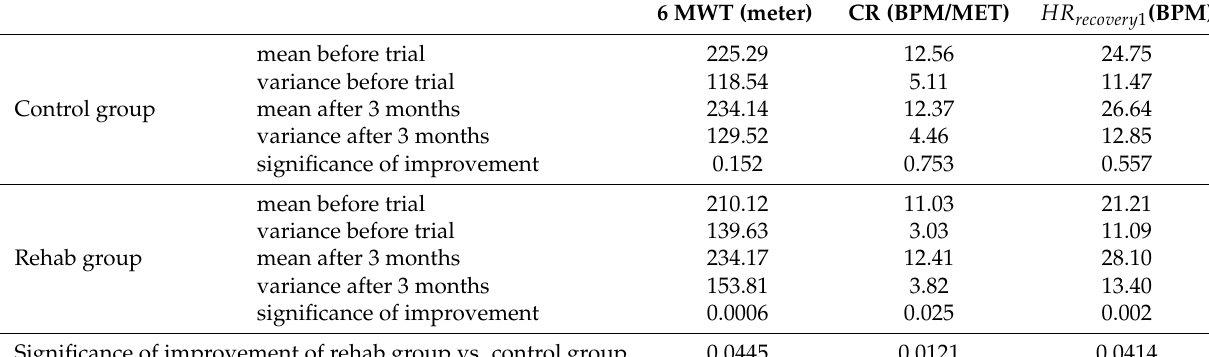
Table 3. Comparison of 3-month rehab results between control group and rehab group under 3CT objective evaluation system. CR: chronotropic